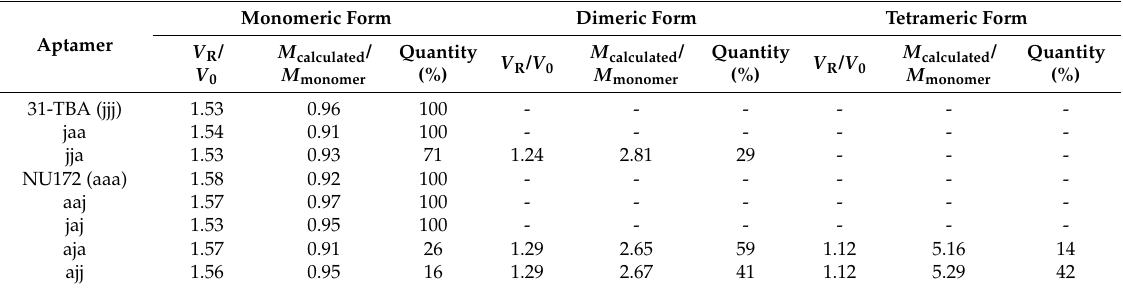
Table 1. Oligomeric composition of bimodular aptamers estimated by size-exclusion chromatography. Aptamer